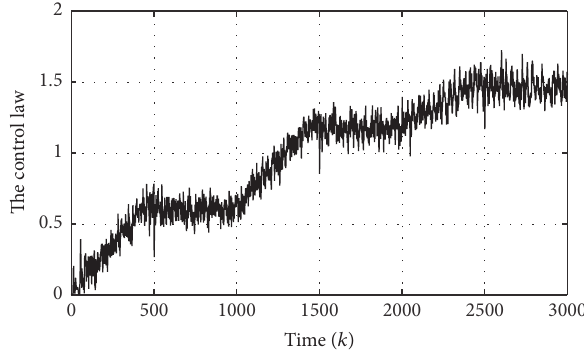
Figure 15: Evolution curve of the control law 𝑢(𝑘)